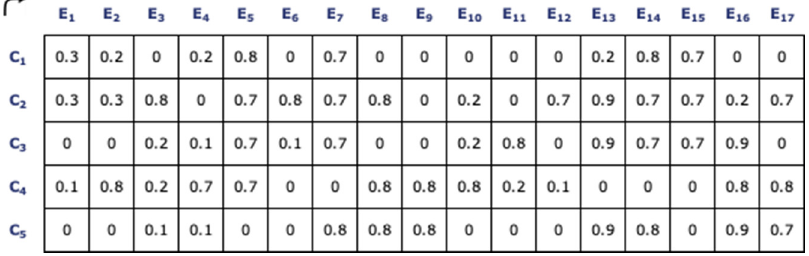
Figure A5. Forgotten Effects matrix.